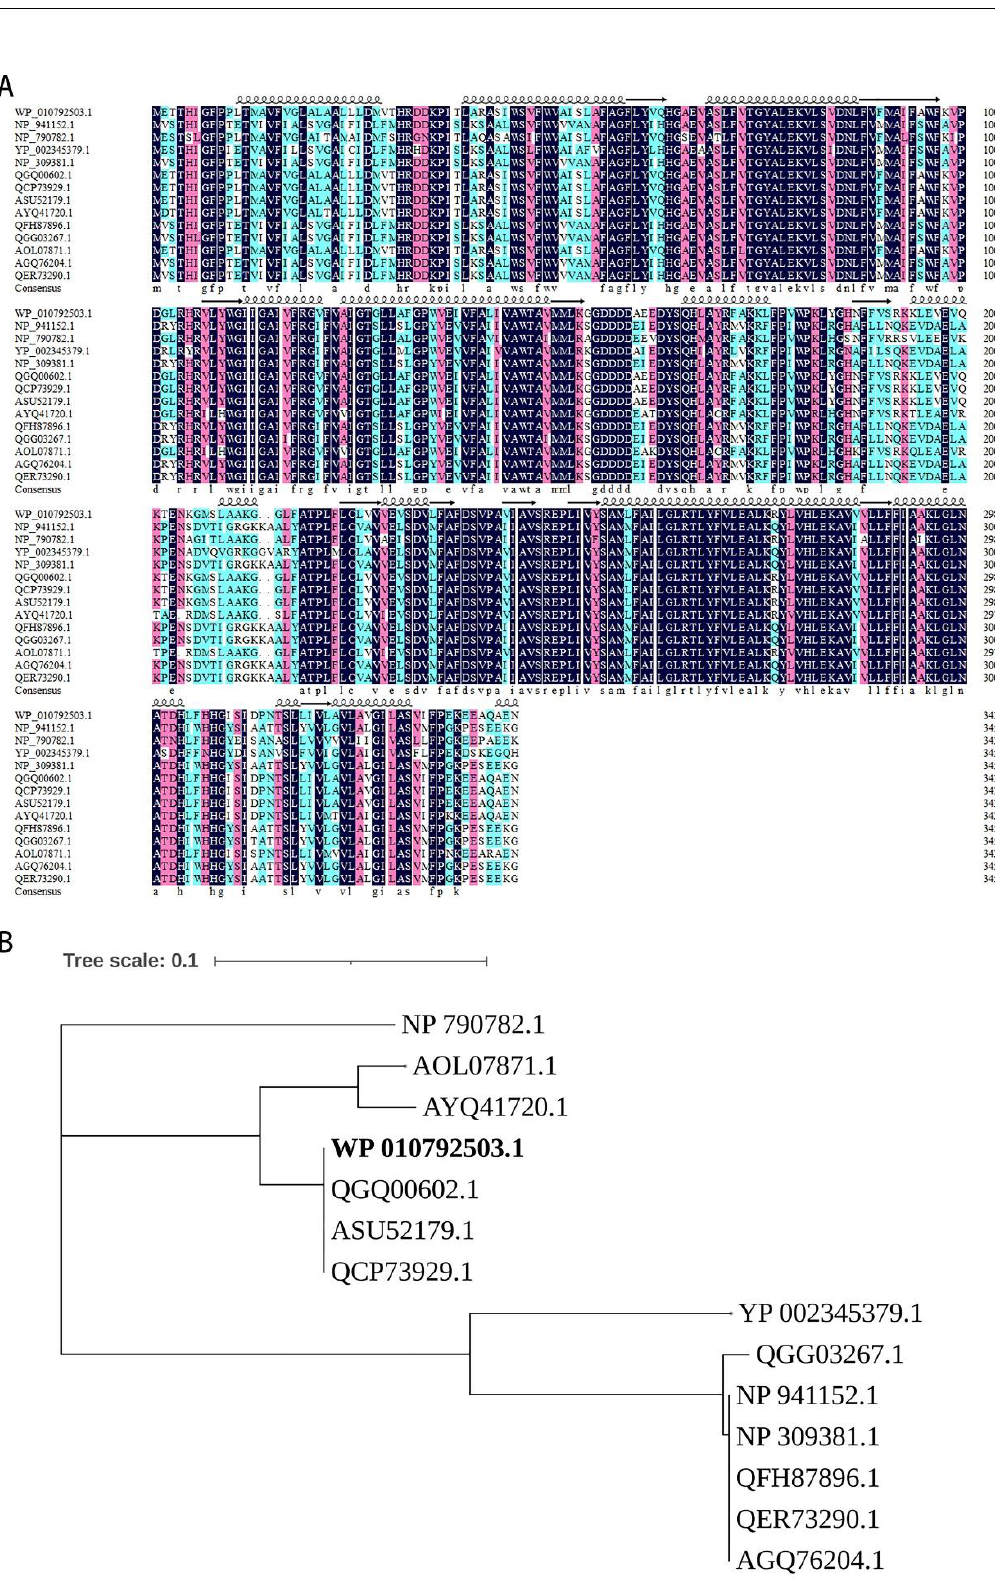
Figure 4. The multiple sequences alignment and the phylogenetic analysis of TerC. ( A ) The sequences of TerC were from P. citronellolis SJTE-3 (WP_010792503.1, bold marked), Serratia marcescens R478 (NP_941152.1), P. syringae DC3000 (NP_790782.1), Y. pestis CO92 (YP_002345379.1), E. coli O157:H7 str. Sakai (NP_309381.1), P. aeruginosa T2436 (QGQ00602.1), P. aeruginosa A298 (QCP73929.1), P. putida SY153 (ASU52179.1), Burkholderia lata A05 (AYQ41720.1), Enterobacter hormaechei E5 (QFH87896.1), Cronobacter sakazakii CFSAN068773 (QGG03267.1), Burkholderia contaminans FL-1-2-30-S1-D0